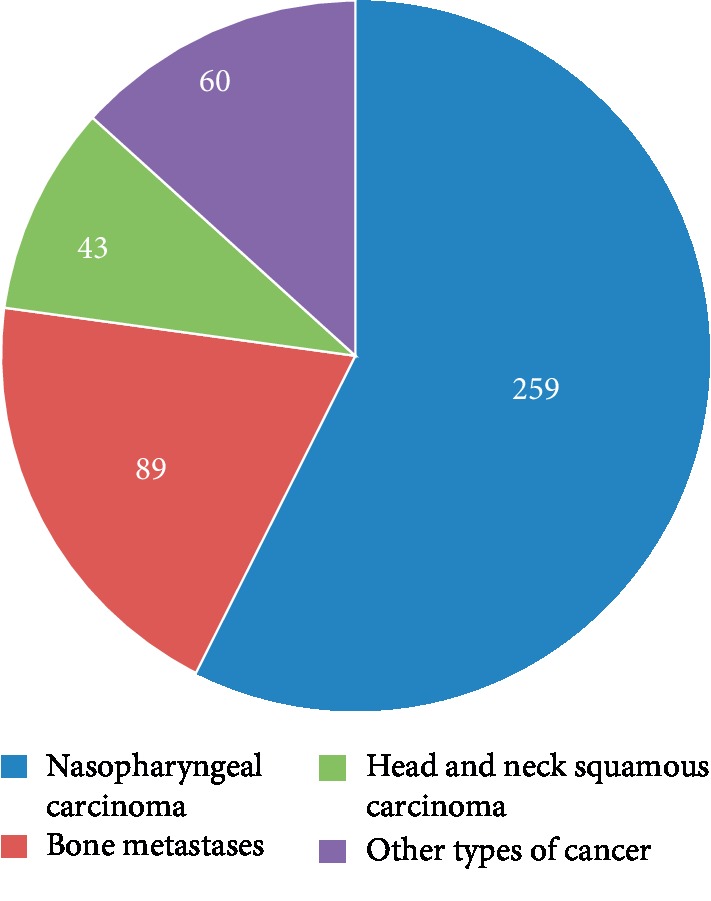
Distribution of the cases in 8 papers.